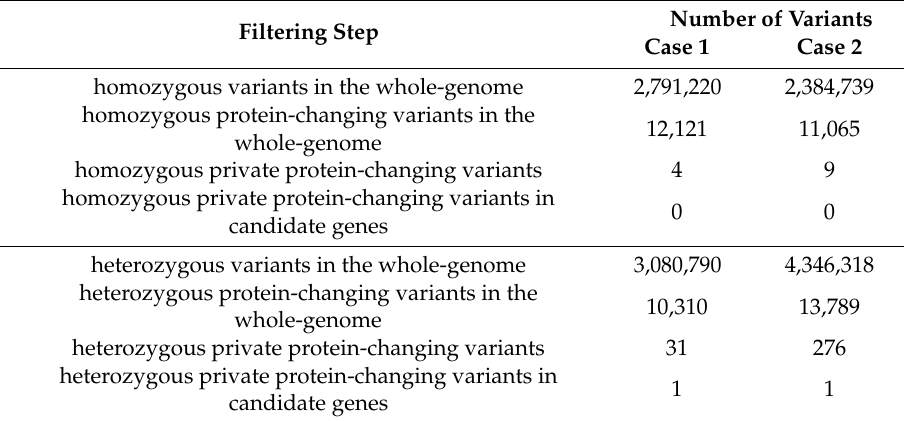
Table 1. Homozygous and heterozygous private genetic variants in case 1 and case 2.